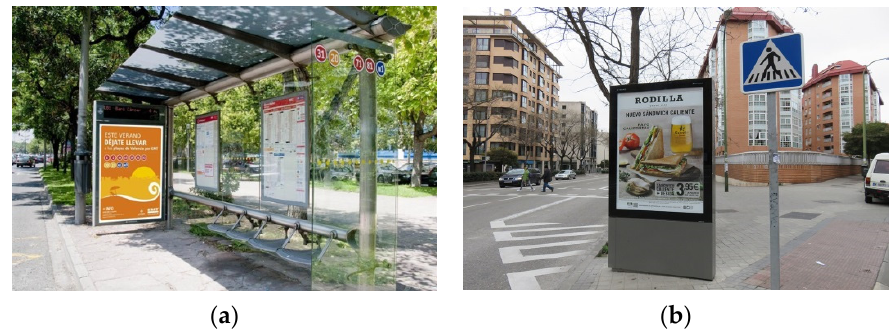
Figure 1. Two examples of Optical Point of Promotion and Information (OPPI) ads panels in urban outdoor images: ( a ) panel as a component of bus stop shelter; ( b ) independent panel. Automatic outdoor detection and localization of OPPI ads panels (named as ‘panels’ for brevity) in real urban outdoor images is a di ffi cult task due to multiple variability conditions presenting in the scenes containing them. For example, variable weather conditions (sunny vs. cloudy), illumination conditions (natural vs. artificial), panel perspective view, size ratio of panels with respect to image size, partial occlusions of panels or complex background in the scene (i.e., presence of multiple elements surrounding the panels like buildings, shadows, vehicles and / or di ff erent infrastructures), among other